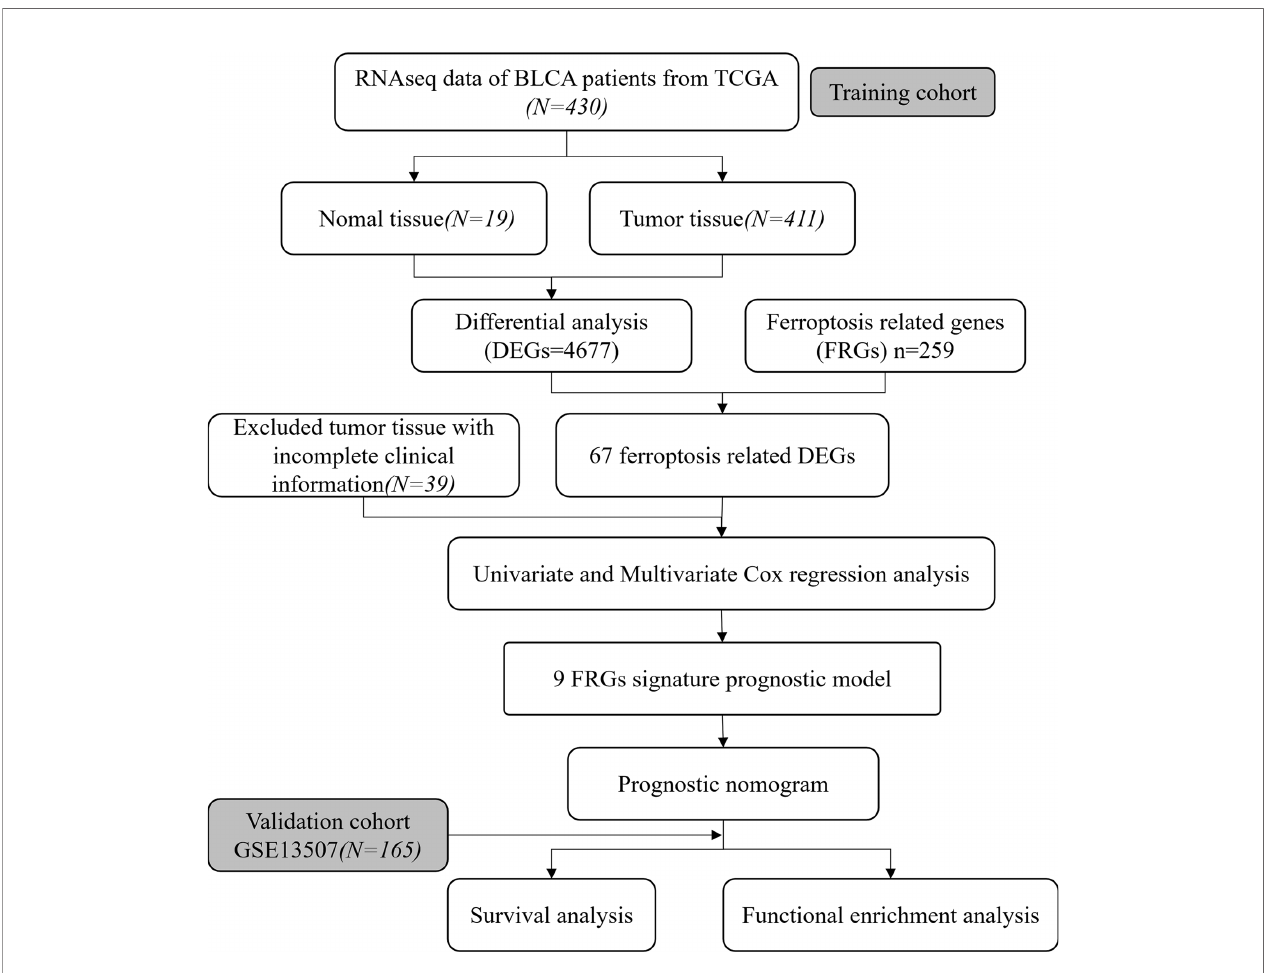
FIGURE 1 | Flow chart of our